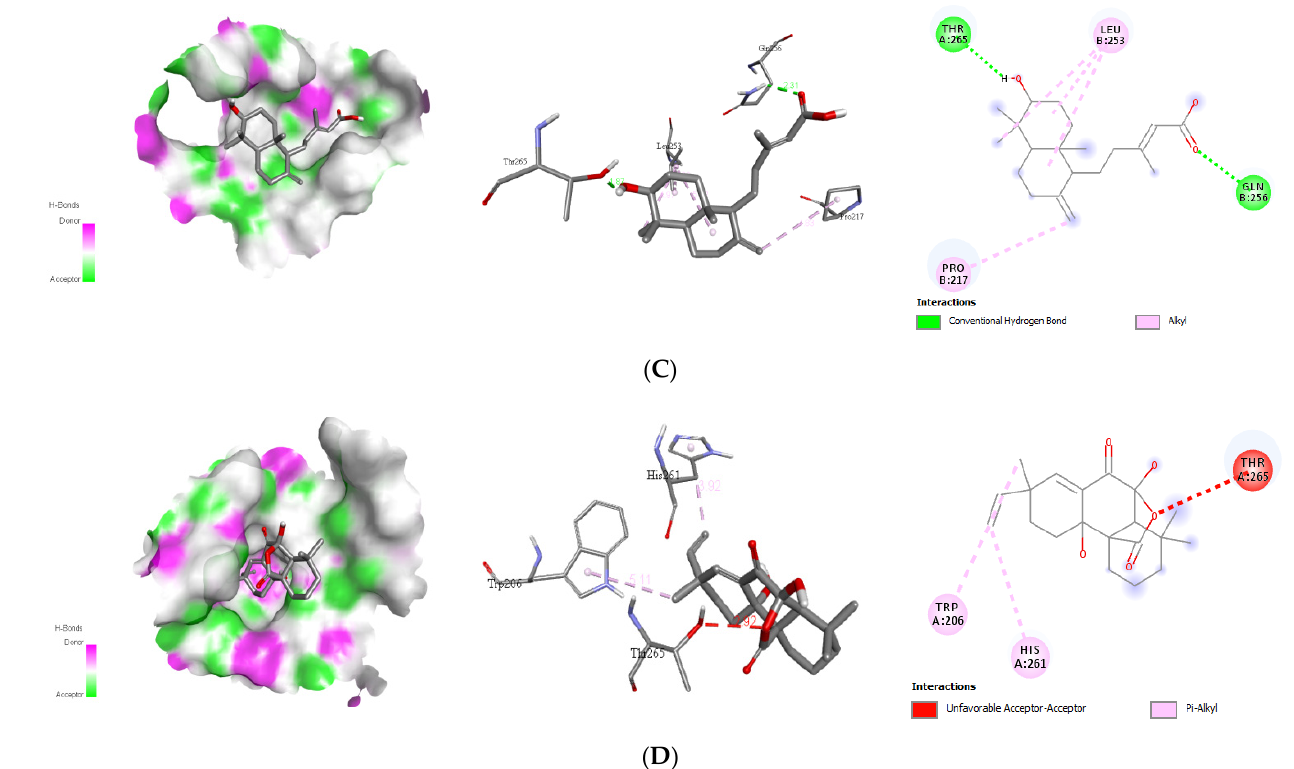
Figure 3. Binding poses of four top-ranked compounds at the binding site of the dengue virus envelope (E) protein (PDB ID: 1OKE) and 2D and 3D interaction diagrams. ( A ) triptolide-E protein; ( B ) stevioside-E protein; ( C ) alepterolic acid-E protein, and ( D ) sphaeropsidin A-E protein.